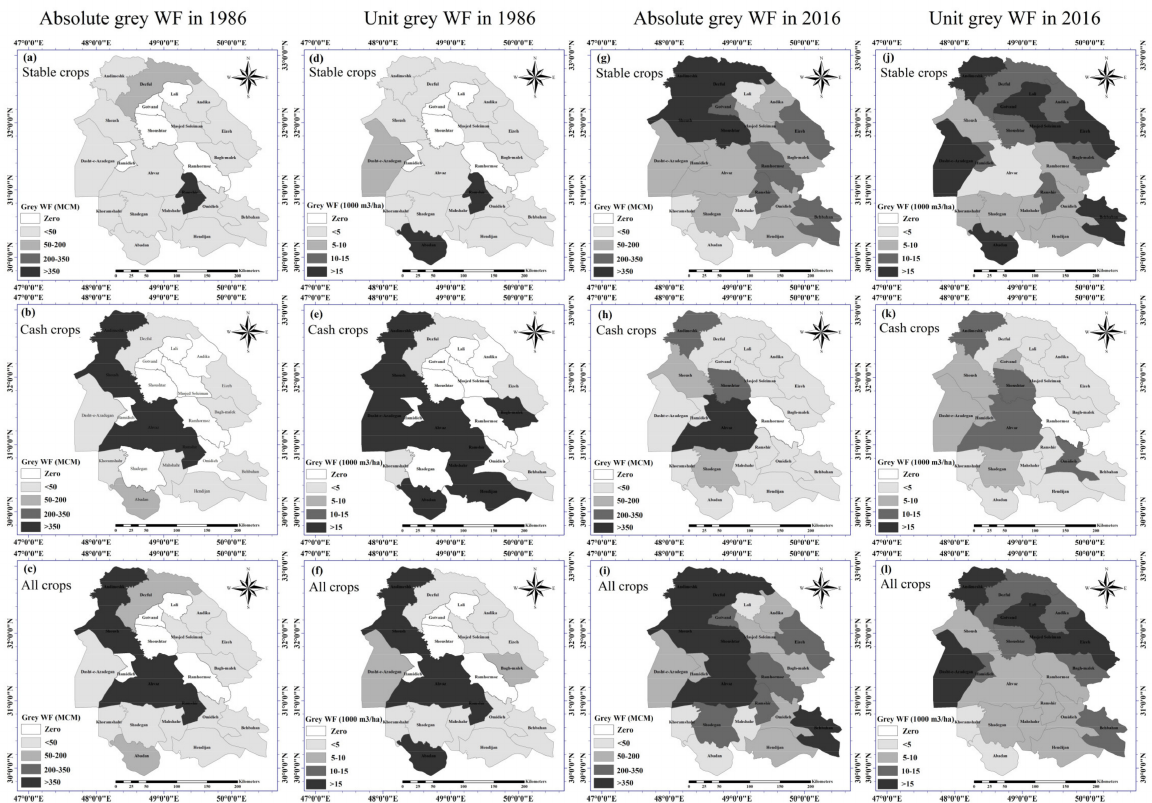
Figure 10. Spatial variation of total (m 3 y − 1 ) ( a – c , g – i ) and unit (10 3 m 3 ha − 1 ) ( d – f , j – l ) variation of total (m 3 y − 1 ) and per capita (m 3 cap − 1 ) grey WF related to staple/cash crop production in the Khuzestan province in 1986 and